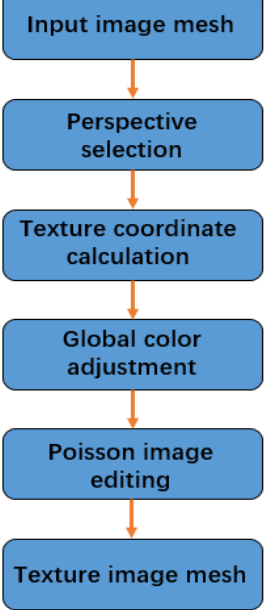
Figure 7. The flow chart of texture-creation algorithm.